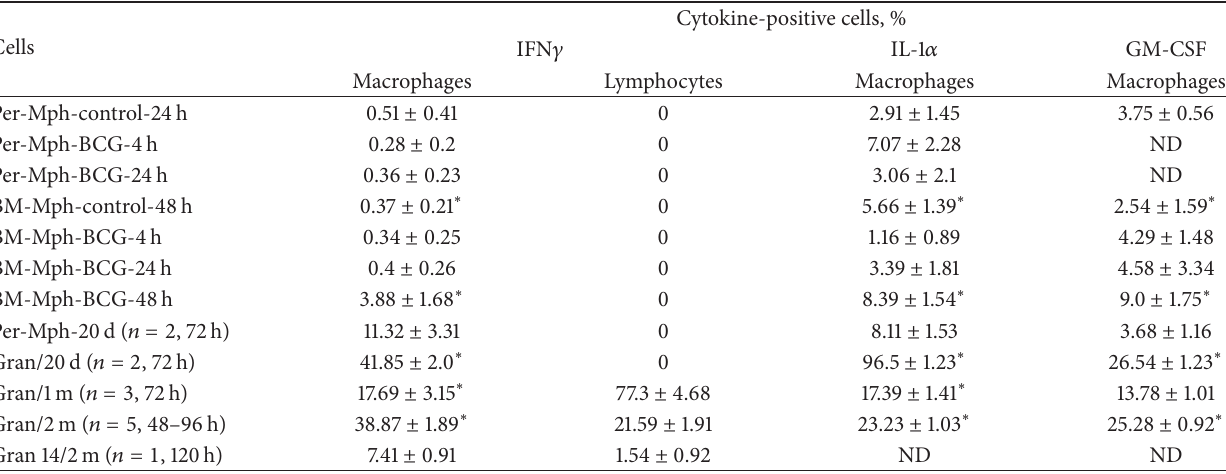
Data are presented as the mean percentage of the number of cytokine-positive cells out of the macrophage population in the granulomas from different mice or in the cultures of mouse peritoneal and bone marrow macrophages, and the standard error of the mean. In each experiment, more than 1000 cells